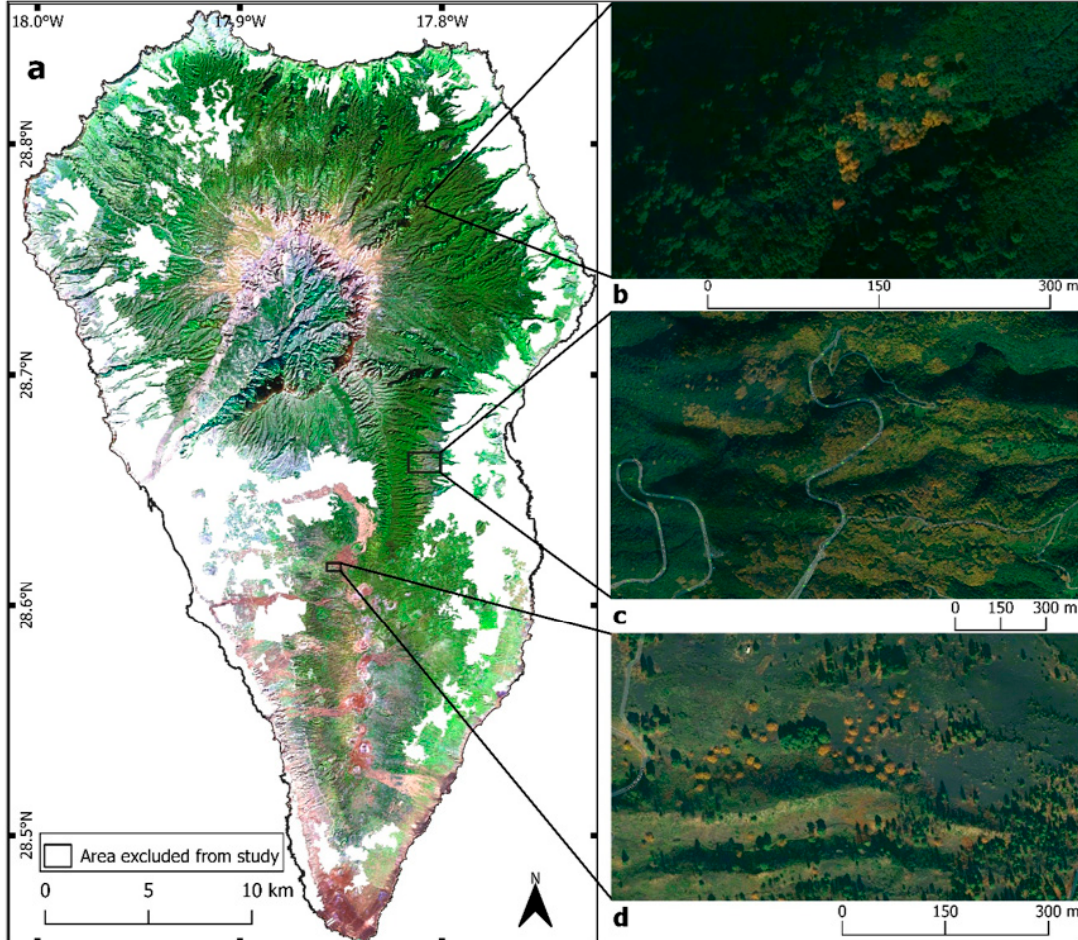
Figure 1. ( a ) Sentinel-2 true natural colour image of the study area (Red: band 4, Green: band 3, Blue: band 2). ( b – d ) are Google satellite zooms of characteristic landscape units. Trees with yellow canopy in the boxes ( b – d ) represent single trees, groups or patches of C. sativa